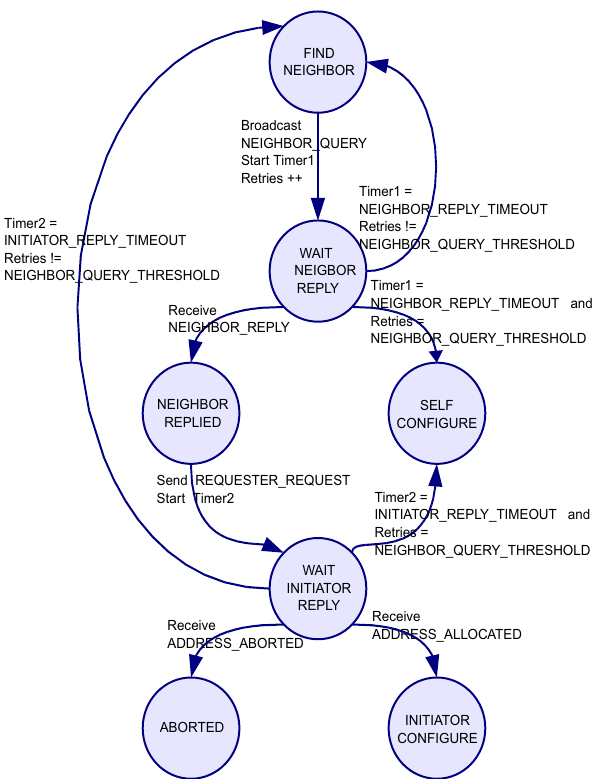
Figure 1. State diagram of a requester node during the address allocation process of MANETconf protocol.